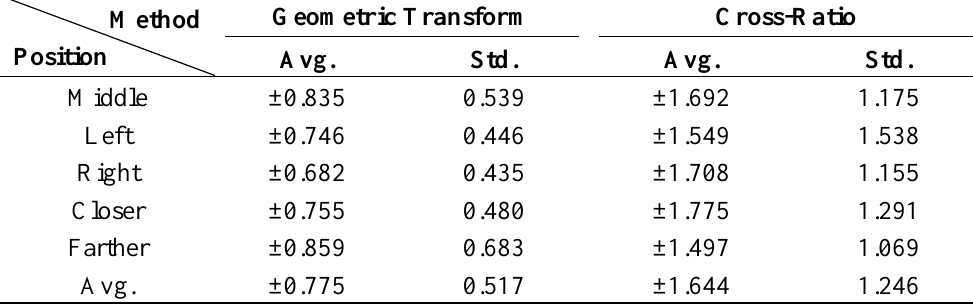
Table 5. Comparisons of gaze tracking error by our geometric transform-based method to that by cross-ratio based one in each sitting position—(1) (10 subjects) (unit: